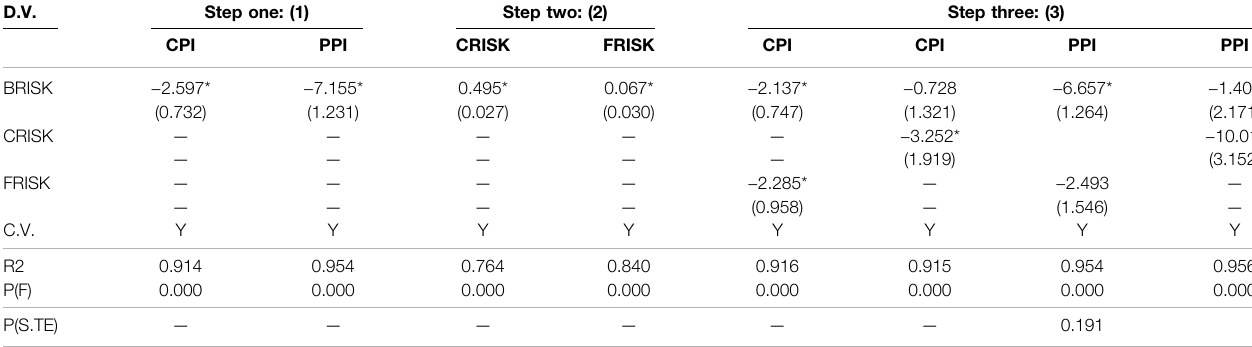
TABLE 3 | Channel effect test of commodity market risk and fi nancial market risk for the full sample.